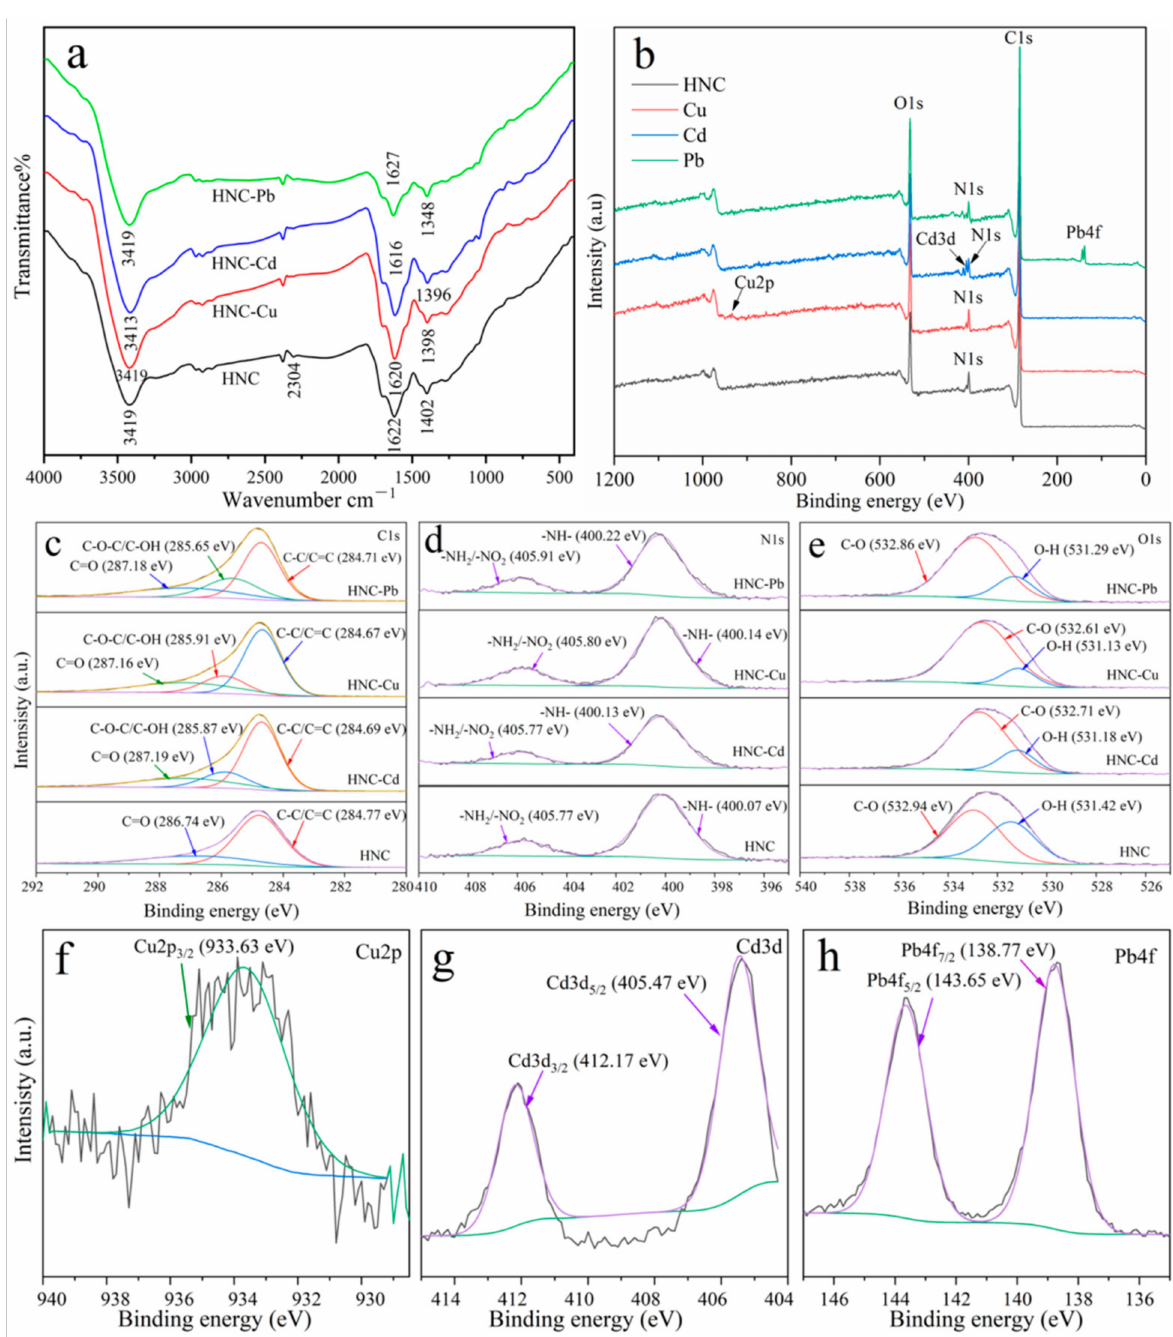
Figure 7. Adsorption mechanism for Cu 2+ , Cd 2+ and Pb 2+ by HNC. FT-IR spectra ( a ) and full XPS spectrum ( b ) of HNC before and after the adsorption of Cu, Cd and Pb; high-resolution XPS spectrum of C1s ( c ), O1s ( d ) and N1s ( e ) of HNC before and after the adsorption of Cu, Cd and Pb; high-resolution XPS spectrum of Cu ( f ), Cd ( g ) and Pb ( h ) after the adsorption by